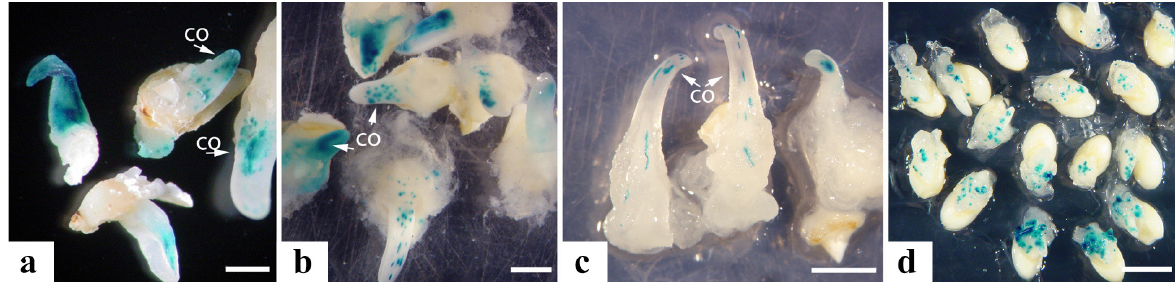
Figure 1 - Expression of gene gus in Brachiaria brizantha cv. Marandu isolated embryos and seeds after bombardment with pAct1-D: ( a ) embryos cultured for 3 d in induction medium and 48 h after bombardment; ( b ) embryos induced for 3 d before bombardment and cultivated for 10 d after bombardment; ( c ) embryos 20 d after bombardment; ( d ) dehulled seeds 48 h after bombardment. co = coleoptile. Bars: ( a ) 0.5 cm; ( b , c ) 1 cm; ( d ) 2